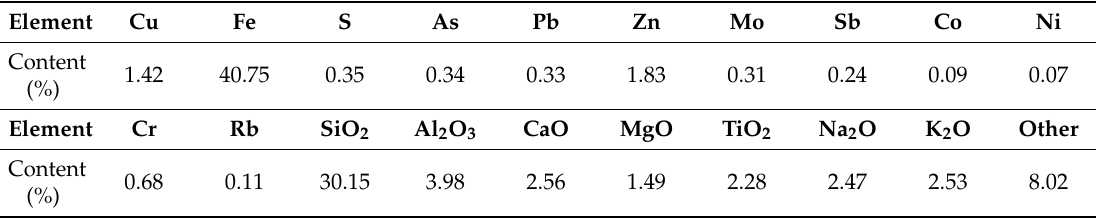
Table 1. Chemical composition of the